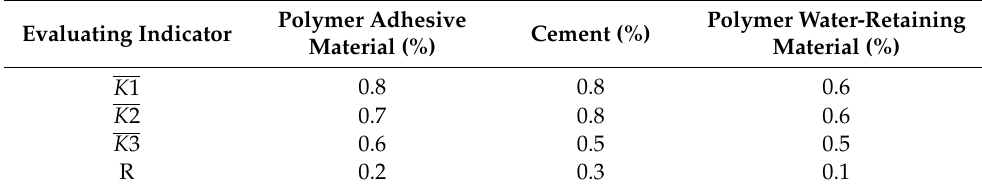
Table 5. Range analysis of erosion resistance test of improved SPC. Evaluating